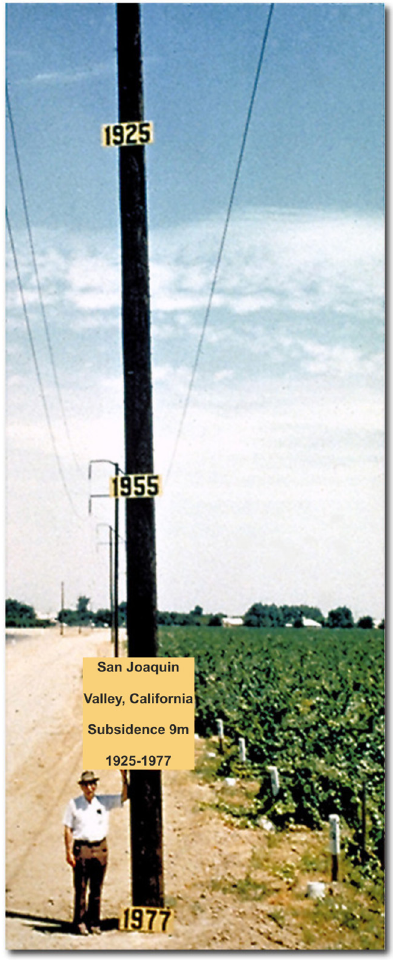
Figure 2. The maximum vertical deformations in the San Joaquin Valley, California. The signs on the column were placed at the approximate former altitudes of the earth’s surface between 1925 and 1977